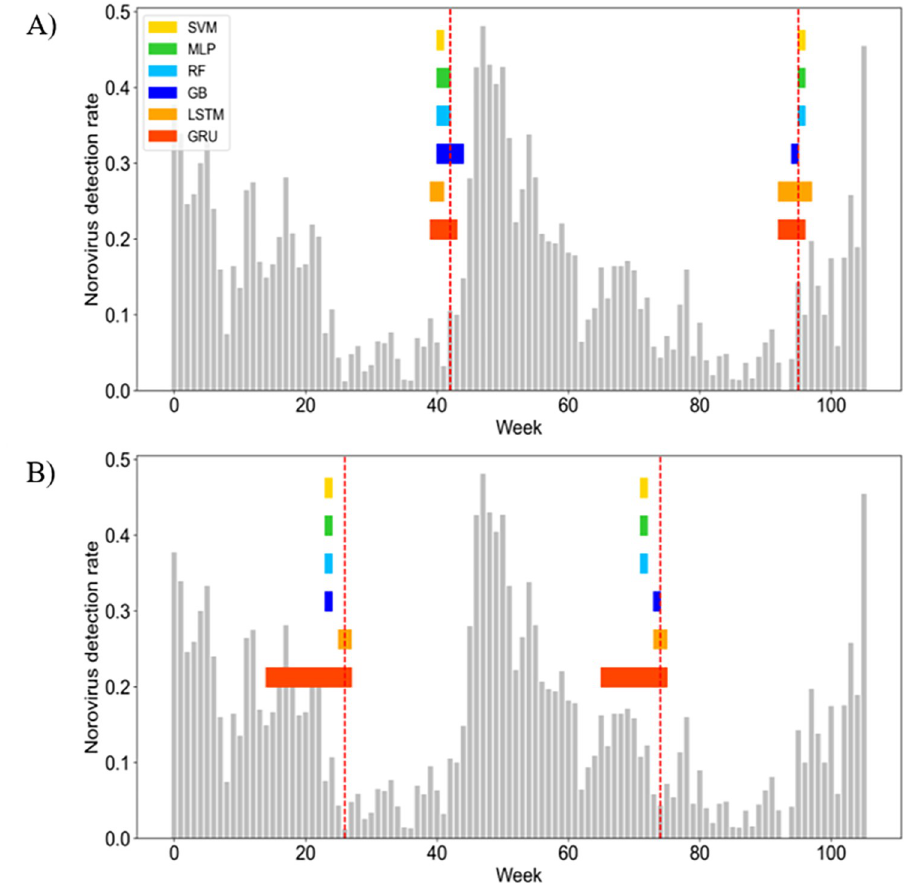
Fig 5. Comparison of early detection of norovirus between six machine learning algorithms for test data. A) start week of early detection and B) end week of early detection. The vertical red dotted lines indicate an observed start and end week of norovirus warning phase. The horizontal color bars indicate a predicted interval for start and end week of norovirus warning phase using SVM (yellow), MLP (green), RF (pale blue), GB (blue), LSTM (orange), and GRU (red). The gray bars indicate an observed weekly detection rate of